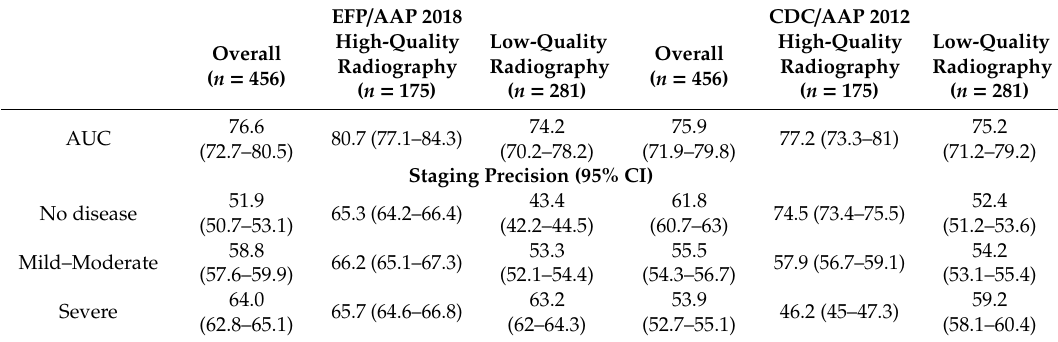
Table 4. OPG performance analysis according to the EFP / AAP 2018 and CDC / AAP 2012 case definitions ( n = 456). Values are expressed as mean and 95% Confidence Interval (95%